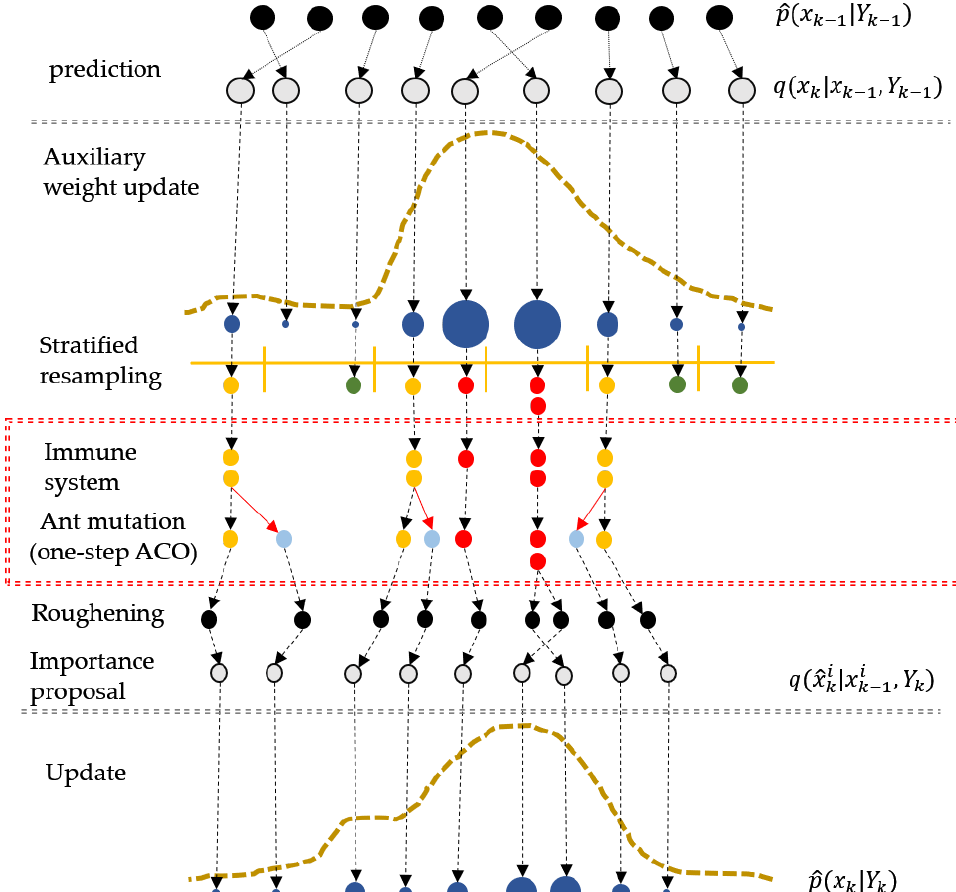
Figure 5. Proposed filter